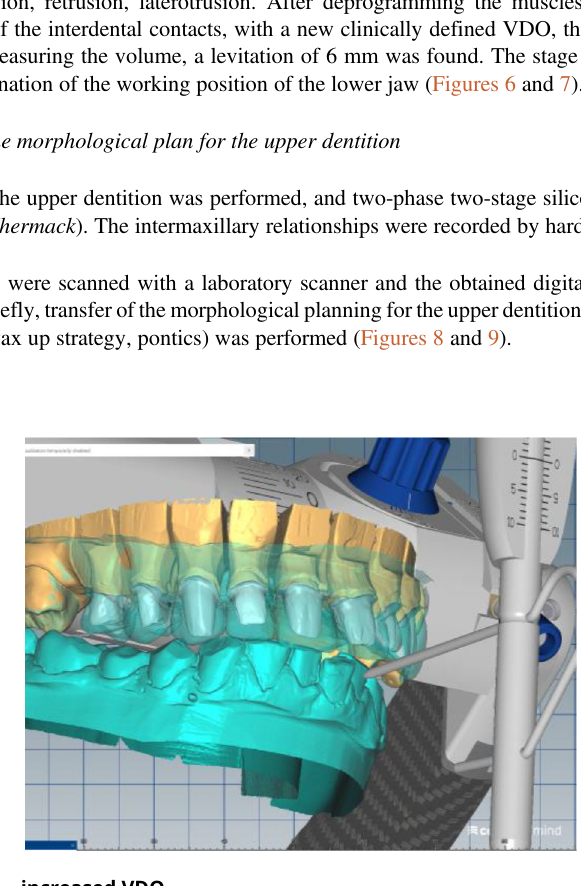
Stage 1: Deprogramming the muscles, determining the treatment position and digital optimization of the working position